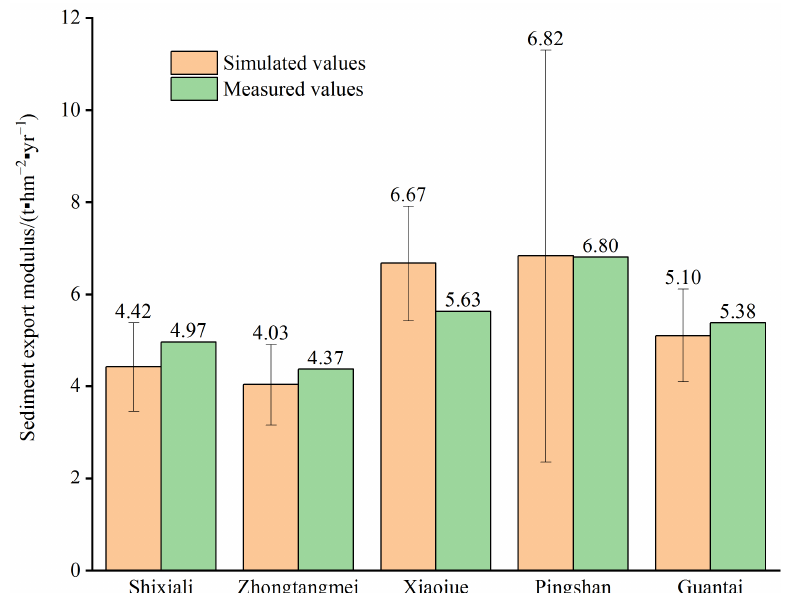
Figure 5. Results of model validation in different basins.